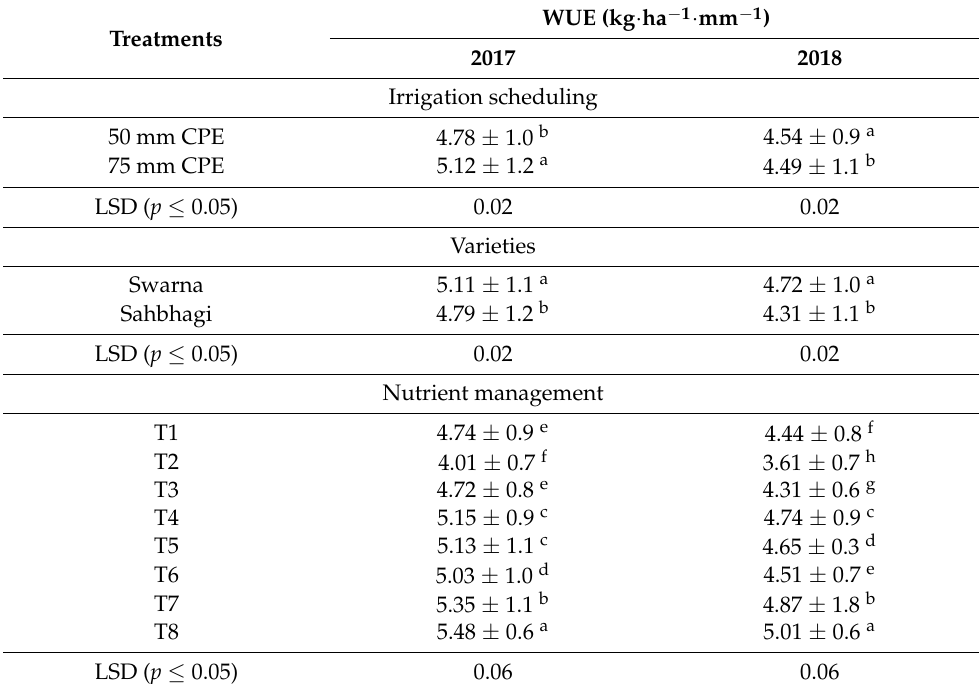
Table 7. Water use efficiency (WUE) is influenced by varied irrigation levels, varieties, and nutrient management practices along with